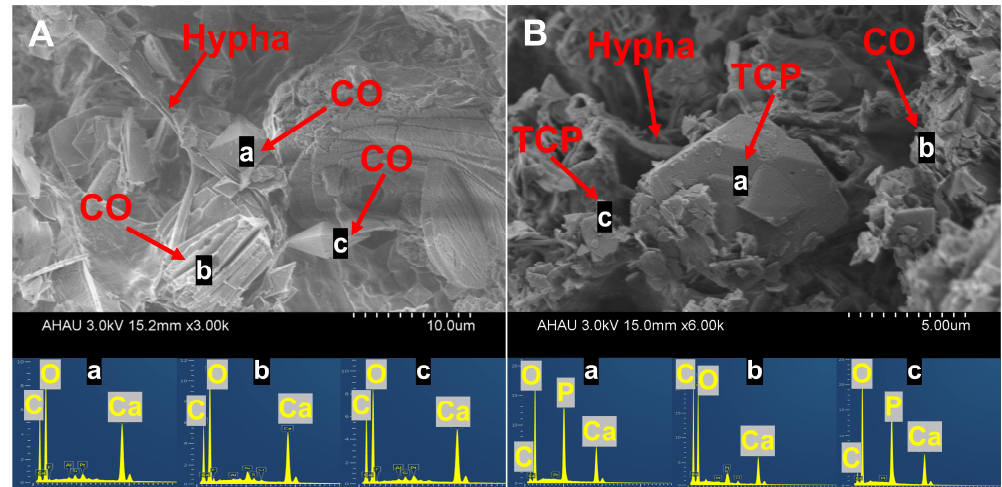
Figure 6. SEM-EDS imaging of the fungus and minerals in ANG + TCP ( A ), ANG + PG ( B ) treatments after 7 days of incubation. Points a, b, and c represent EDS analysis in ANG + TCP ( A ) and ANG + PG ( B ) treatments. CO, calcium oxalate (CaC 2 O 4 ); TCP, tricalcium phosphate (Ca 3 (PO 4 ) 2 ). The SEM images showed the morphology of minerals and fungi in PGF and SS + PGF treatment after four weeks of incubation in the soil incubation experiment (Figure 7). In PG fertilizer (PGF), both A. niger (hyphae and globular spores) and minerals (calcium oxalate and calcium sulfate) were observed (Figure 7A). In SS + PGF treatment, the morphology of soil block, crop straw, fungal hypha and spores were also clearly observed (Figure 7B).